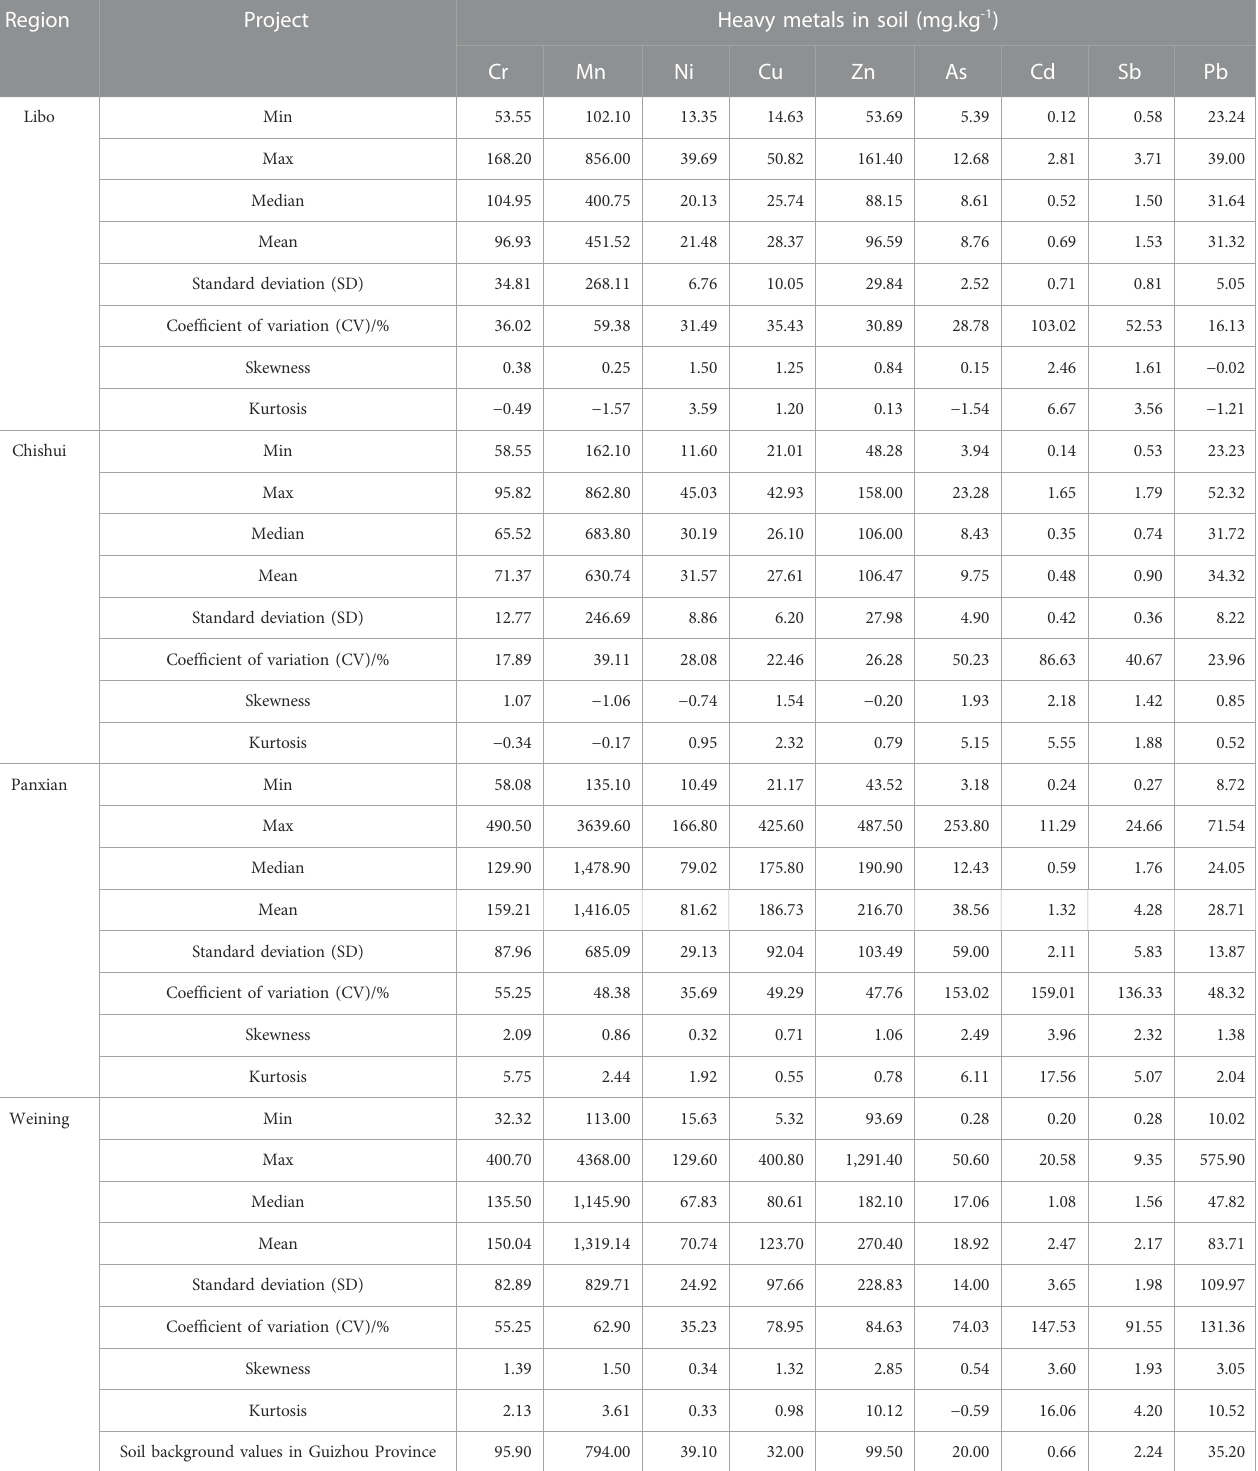
TABLE 1 Descriptive statistics of heavy metal content in the soil (Zeng Q Q et al., 2021; China General Environmental Monitoring Station 1990). Region Project Heavy metals in soil (mg.kg -1 )